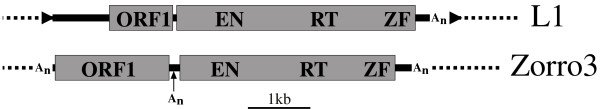
Structures of the human L1 element and Zorro3 of C. albicans. Shaded boxes represent ORFs; the approximate positions of conserved protein-coding domains are indicated. The ORFs are flanked by untranslated regions (thick black lines). The border between the 3' UTR of each element and flanking genomic DNA (dashed lines) consists of a poly-A tract (An). Zorro3 also has a poly-A sequence at its 5' end and between its ORFs. The L1 element is flanked by short duplications of the target sequence (black triangles).